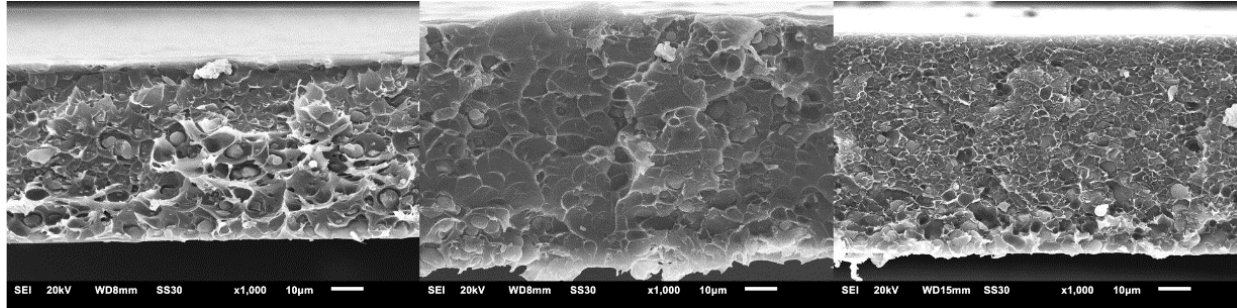
Figure 1. Cross-section SEM images of 8 wt% ( left ), 16 wt% ( middle ), and 24 wt% ( right ) CTF/Matrimid ® MMMs. The cross-sections were formed by breaking the membrane through freeze-fracturing after cooling in liquid